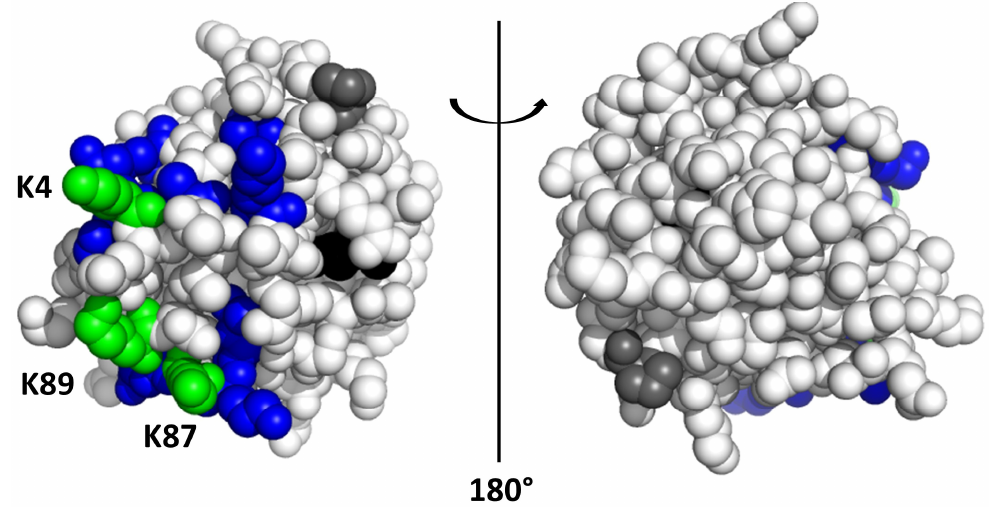
Figure 3. Binding map for compound 1 on cytochrome c . K4, K87, and K89 are colored green, and other residues with a significant chemical shift perturbation ( Δδ 1 H N ≥ 0.04 or 15 N H ≥ 0.4 ppm) are blue. The heme and prolines are black and grey, respectively.